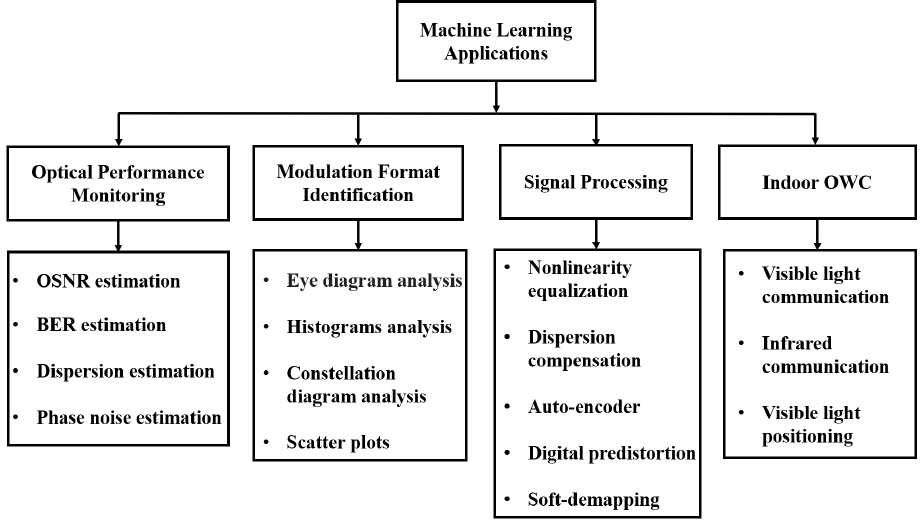
Figure 2. Machine learning applications in optical